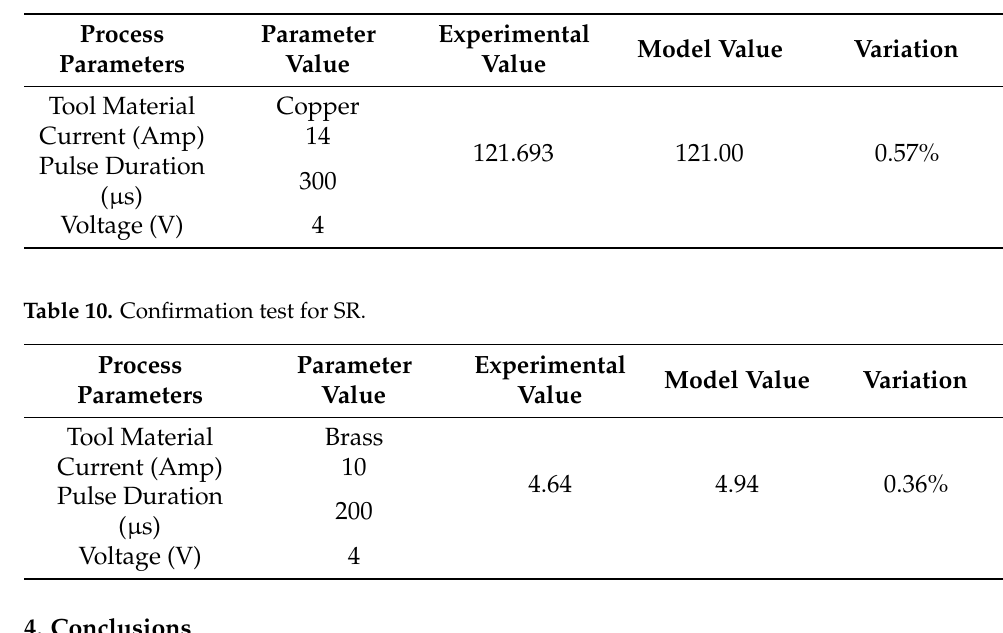
Table 9. Confirmation test for MRR.